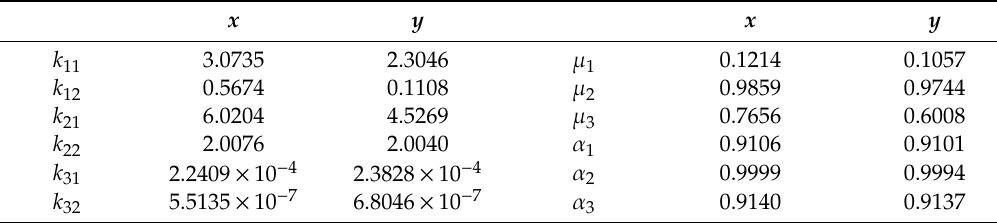
Table 6. NLPID parameters for the x − y position of the leader